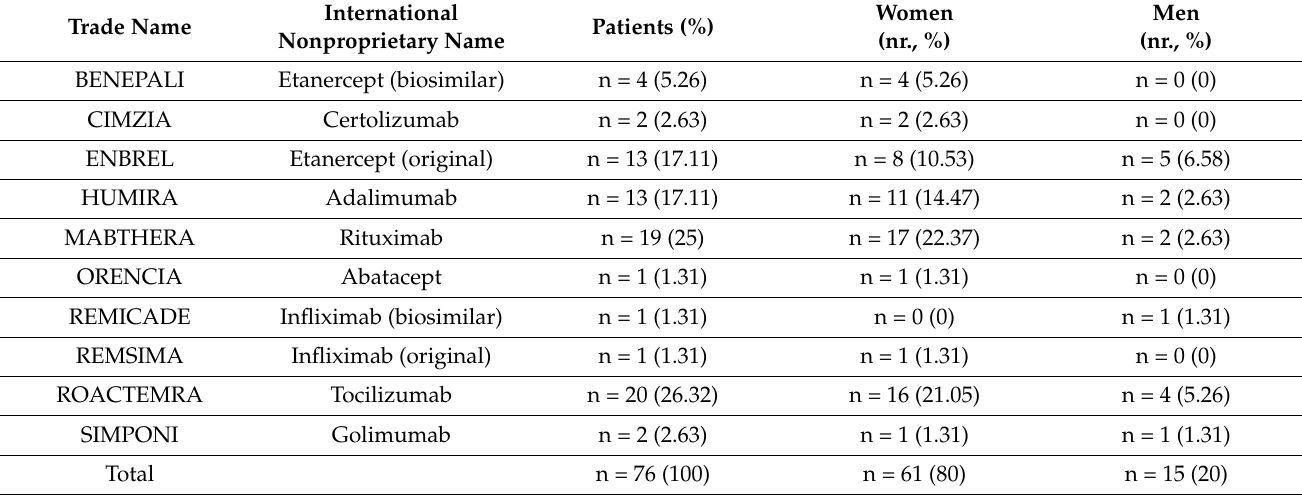
Table 3. Distribution of RA patients by gender and the biological therapy followed at the end of the